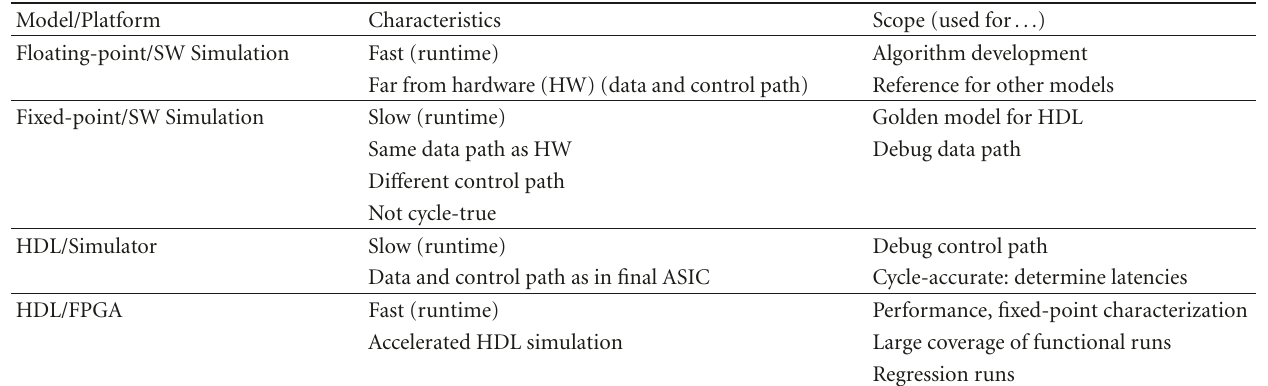
Table 1: Characteristics of di ff erent transceiver simulation